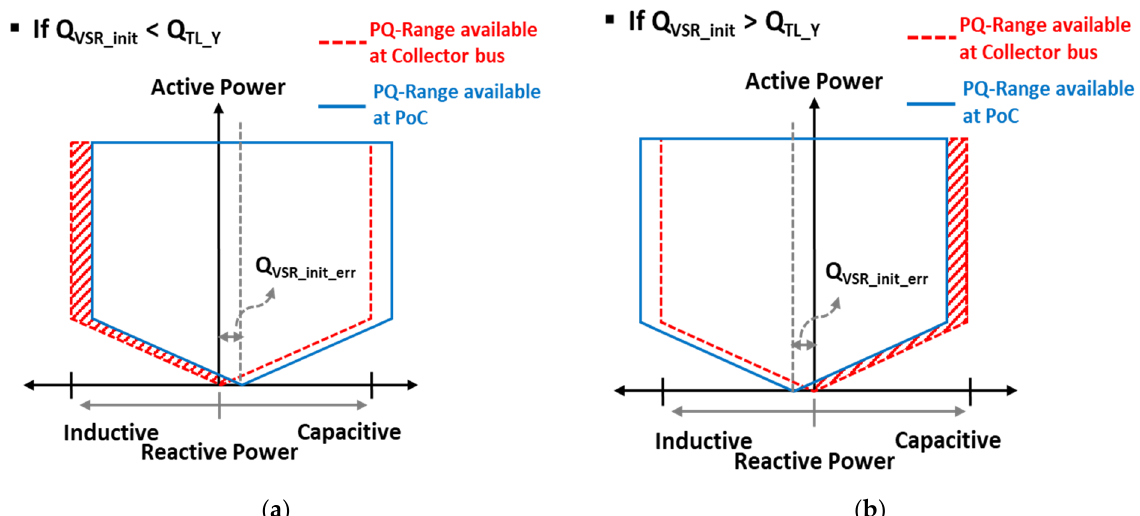
Figure 9. Hysteresis control concept diagram; ( a ) Hysteresis control setting when cable reactive power compensation error of the VSR is capacitive; ( b ) Hysteresis control setting when cable reactive power compensation error of the VSR is inductive.